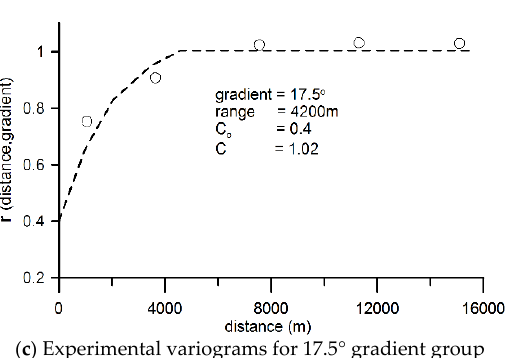
Figure 4. Experimental distance/orientation-based variograms. 0 °, 45°, 90°, and 135° (measured clockwise from north) are the four orientations in which the point pairs are searched to calculate the variograms (by Du et al., 2017 [17]).